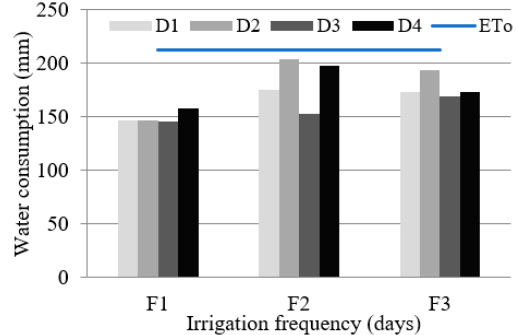
Figure 4. Bean’s actual water consumption, in mm, for each treatment. Irrigation frequencies of one (F1), four (F2), and eight (F3) days. Planting densities of 20 (D1), 24 (D2), 28 (D3), and 30 (D4) plants per m 2 .